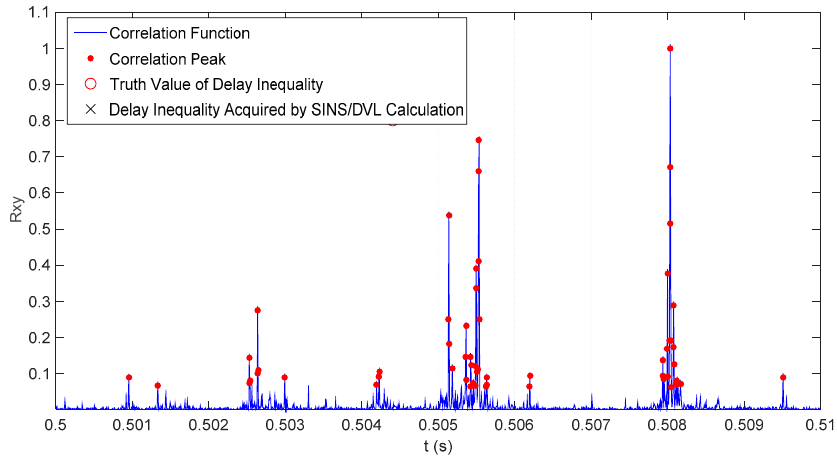
Figure 17. Screening out of the main correlation peak. Table 1. Comparison of the calculation results of the time differences.